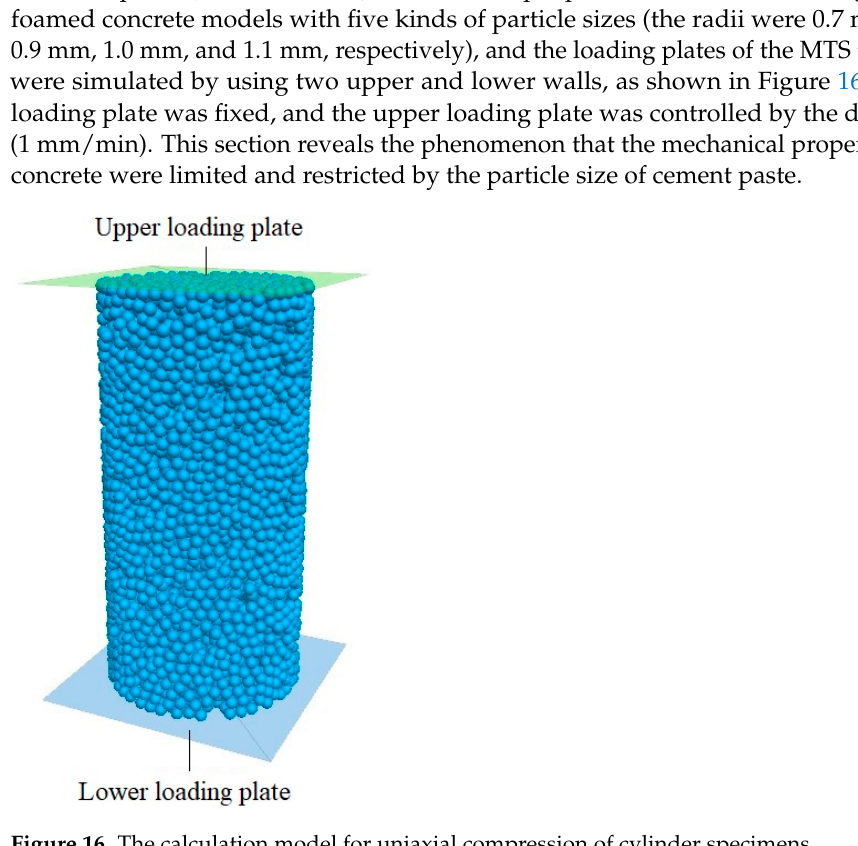
Figure 17. Stress-strain curves of the foamed concrete models with five kinds of cement paste sizes.